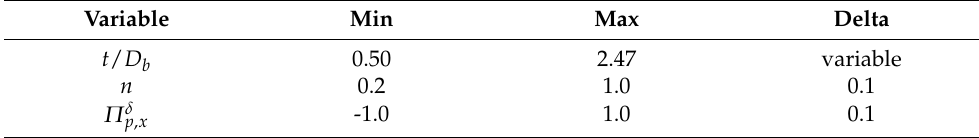
Table 2. The ranges of variation for t / D b , n , and Π δ p , x for Data Set 1. Variable Min Max